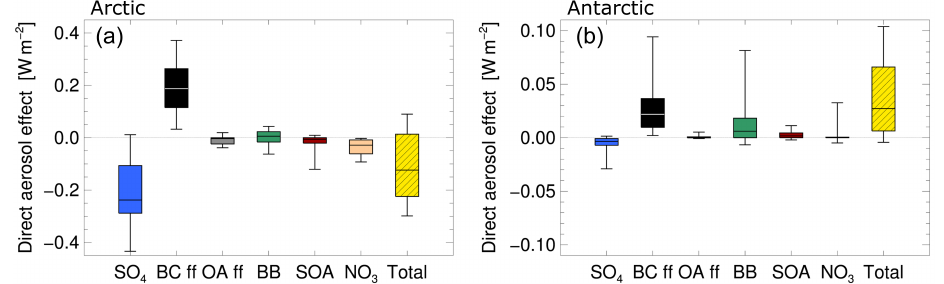
Figure 12. Annual mean multi-model DAE (in Wm − 2 ) averaged over the Arctic (60–90 ◦ N) (a) and the Antarctic (70–90 ◦ S) (b) for the individual components (sulfate, BC FF, OA FF, BB, SOA, and nitrate) and the total aerosol. The bottom and top of each box are the first and third (25th / 75th) quartiles, and the band inside the box is the model median. The whiskers represent the minimum and maximum of the model range. Note the different vertical